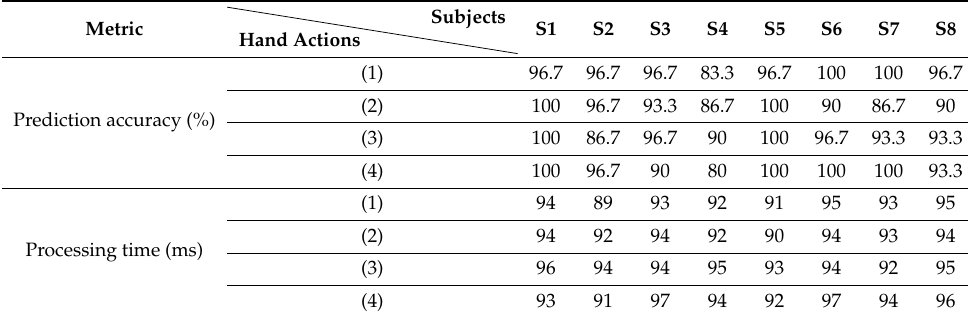
Table 4. Average prediction accuracy and processing time of continuous four-hand